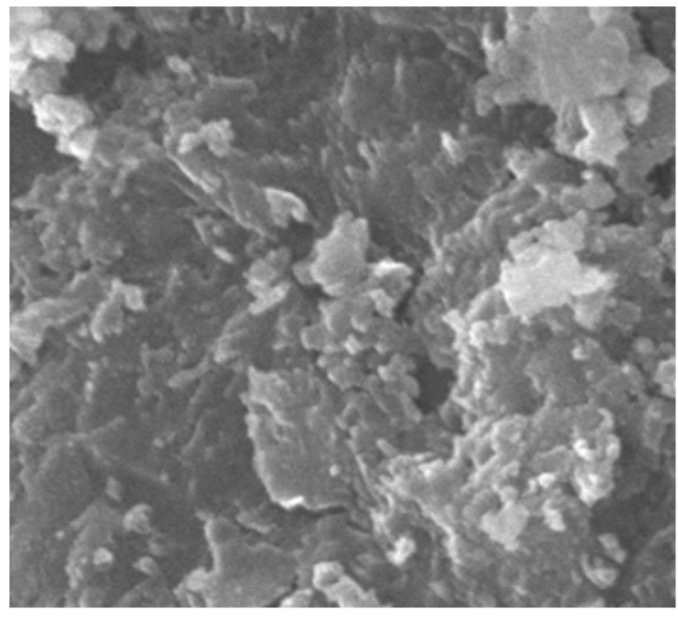
Figure 15. Normal concrete.